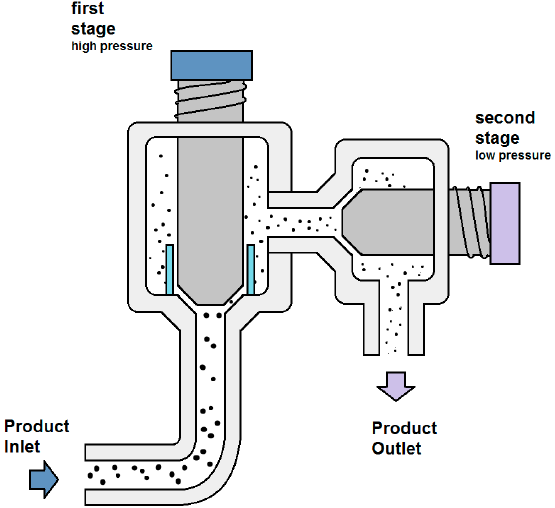
Figure 1. Scheme of a two-stage high pressure homogenizer. Modified From Plazzotta and Manzocco [13].